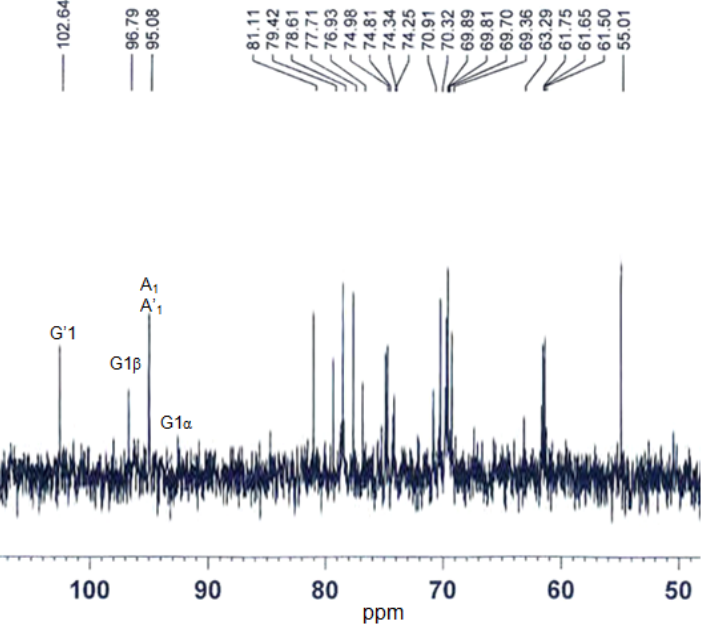
Figure 8. 13 C-NMR spectrum of the κ-carrageenase degradation products. The degradation products were dissolved in 2 H O and processed at 30 °C. Spectrum was recorded on an 2 AVANCE 500 MHz apparatus (Bruker, Karlsruhe,